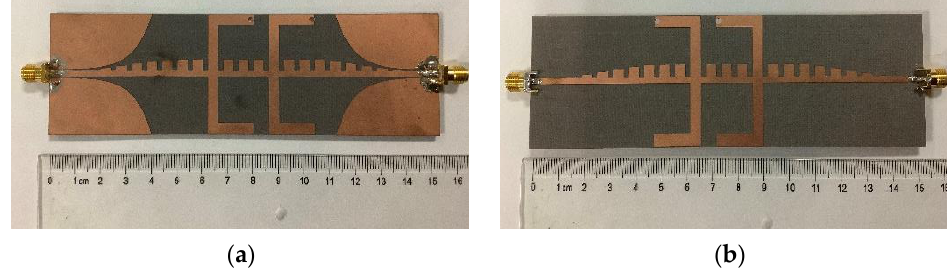
Figure 12. Photographs of the fabricated broad dual-band filter sample. ( a ) Top view. ( b ) Bottom view.